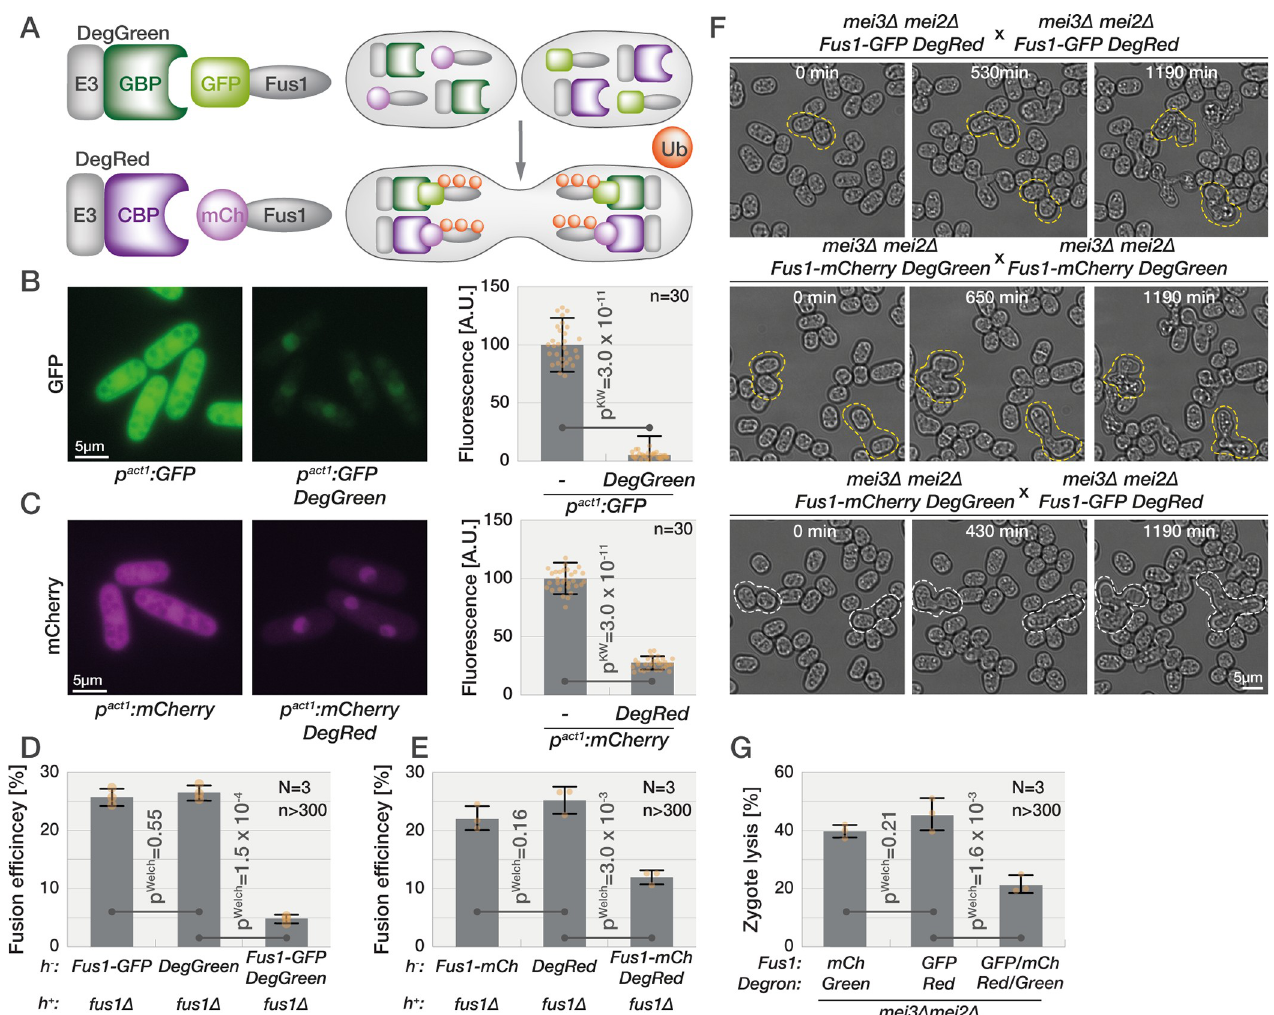
Fig 2. Zygote lysis is induced by aberrant fusion attempts. (A) Schematic of the artificial degron system. The DegGreen construct composed of the N- terminal, E3 ligase domain of Pof1 (E3, gray) fused with the GFP-binding nanobody (GBP, dark green) targets GFP (light green; here linked to Fus1) for degradation. Similarly, the DegRed construct, consisting of the E3 ligase domain of Pof1 (E3, gray) fused with the mCherry-binding nanobody (CBP, dark purple), targets mCherry (light purple) for degradation. For zygote-specific protein depletion, 1 partner gamete carries DegGreen and the mCherry-tagged protein of interest, while the other partner brings DegRed and the GFP-tagged protein of interest. Ubiquitination (orange circles) and degradation only happens postfertilization. (B and C) Exponentially growing cells expressing GFP (B) or mCherry (C) from the strong p act1 promoter without (left) or with DegGreen (B) or DegRed(C) (right). The graph shows the fluorescence normalized to cells without degron systems. Dots show individual measurements, bars mean values, and error bars standard deviation. p -Values for indicated comparisons were obtained from the Kruskal–Wallis test. (D and E) Gamete fusion efficiency between h− strains with incomplete or complete (right) Fus1 degron systems and h+ fus1 Δ . Dots show individual replicates, bars mean values, and error bars standard deviation. p -Values for indicated comparisons were obtained from the Welch test. (F) Mating of mei3 Δ mei2 Δ gametes carrying the indicated halves of the Fus1 artificial degron system. Zygotes with the incomplete Fus1 degron (top and middle panels) undergo cell lysis (examples outlined in yellow), whereas zygotes with a complete Fus1 degron postfertilization (bottom panel) prevent lysis (examples outlined in white). (G) Frequency of lysis in mei3 Δ mei2 Δ zygotes with incomplete or complete degron systems (genotypes as in (F)). Data are presented as in (D). The data underlying this Figure may be found at